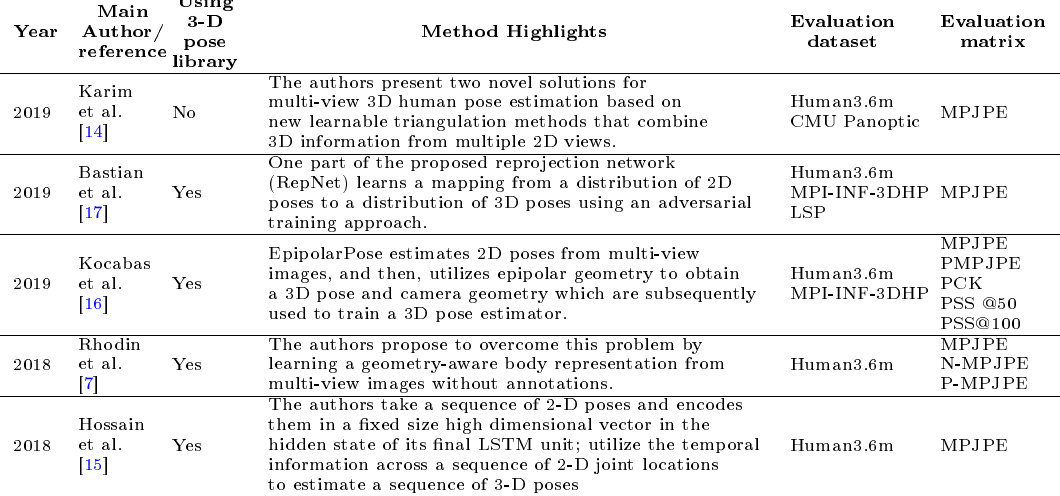
Tab. 3: Survey: 3-D human pose estimation from a sequence of